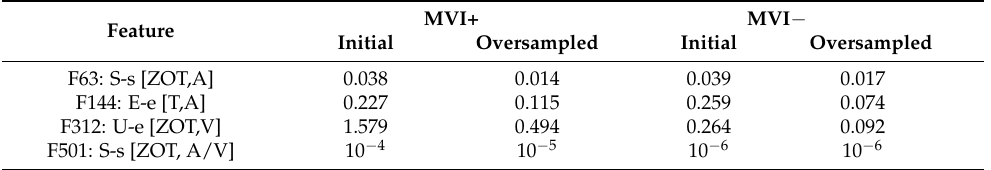
Table 2. Mean square errors (MSEs) between kernel density estimation (KDE) functions and initial and oversampled histograms of the four selected radiomics features, which refer to both tumour (T) regions of interest (ROIs) and zone of transition (ZOT) of arterial (A) and venous (V) phases. MVI+ MVI − Feature Initial Oversampled Initial Oversampled F63: S-s [ZOT,A]